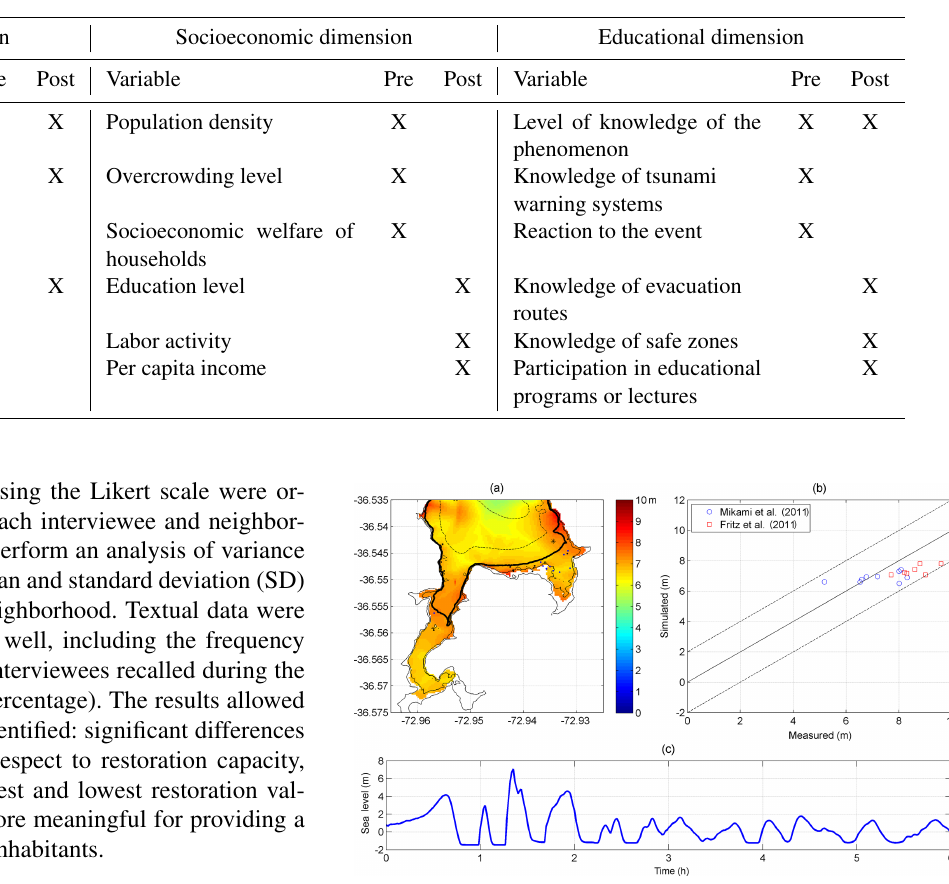
Figure 3. (a) Inundation area obtained in the numerical simula- tion. (b) Comparison of measured and simulated data. (c) Tide gauge on Dichato beachfront. The solid line represents the measure- ment equal to the simulation, while the dotted lines show the mea- surement ± 2m. The simulation shows results in a range of ± 2m with respect to the measured